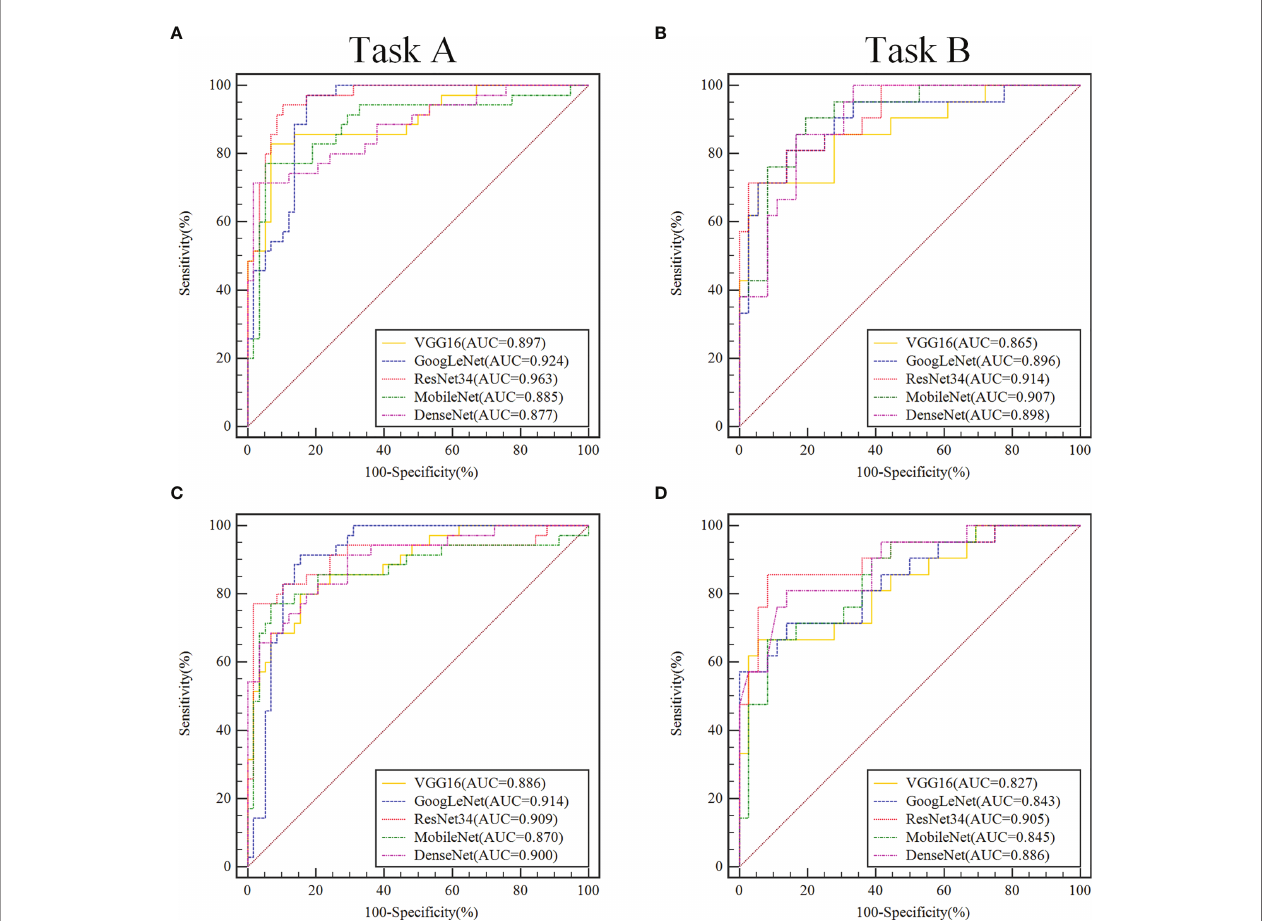
FIGURE 3 | In the validation set, ROC curve analysis of two classi fi cation tasks with different convolutional neural network models before and after transfer learning. Task A (A, C) discriminating benign vs . borderline & malignant, Task B (B, D) discriminating borderline vs . malignant. In the convolutional neural network model, the models that use transfer learning are (A, B) , and the fully trained models are (C, D)